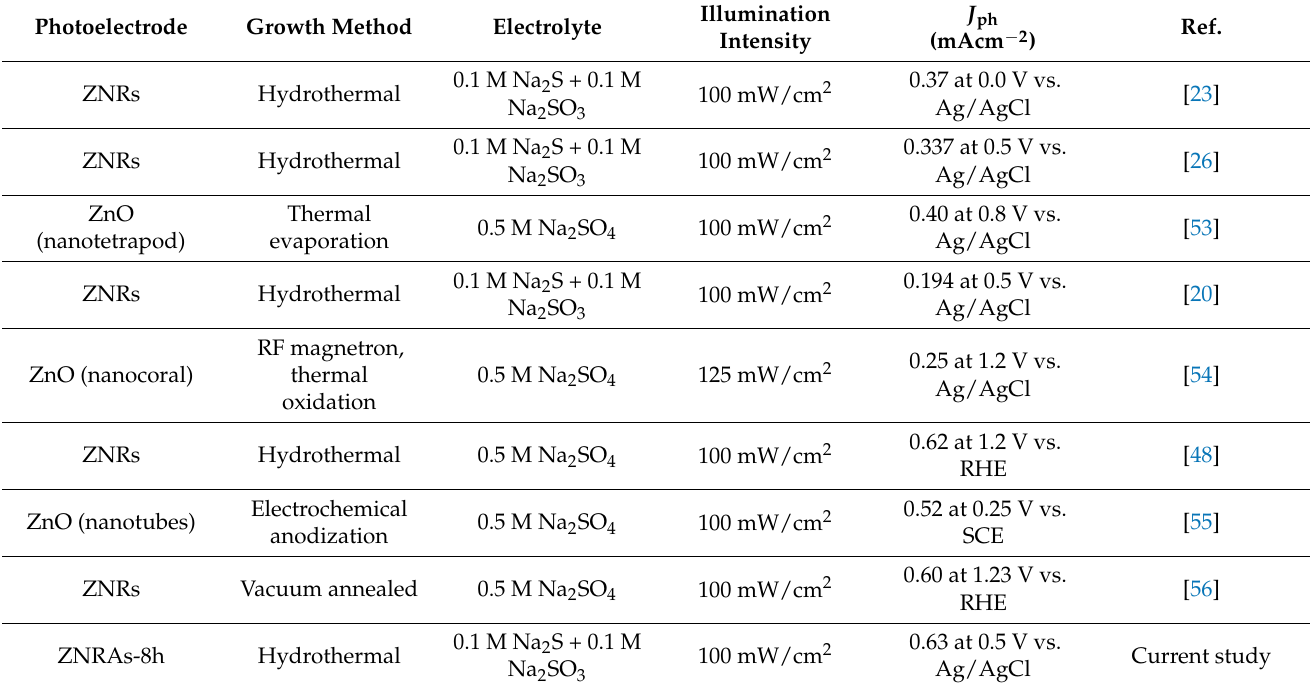
Table 2. Photoelectrochemical water-splitting cell performance of the proposed optimum ZNRAs-8h as the photoanode when compared with other reports in the